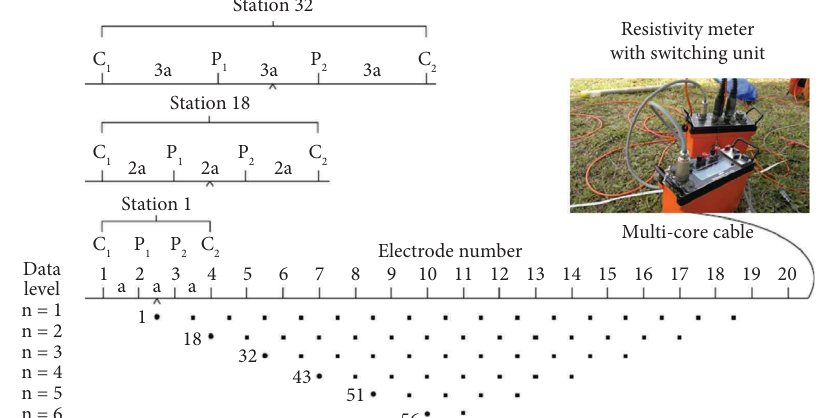
Figure 1: Te schematic diagram for 2D resistivity survey and sequence measurement using Wenner confguration [22].